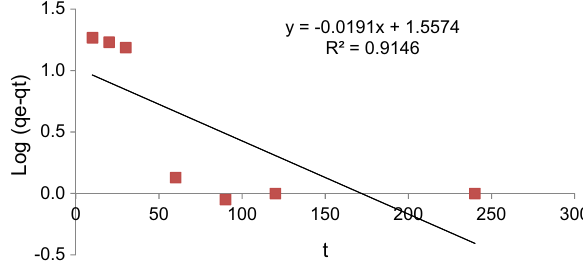
y = -0.0191x + 1.5574 R² = 0.9146